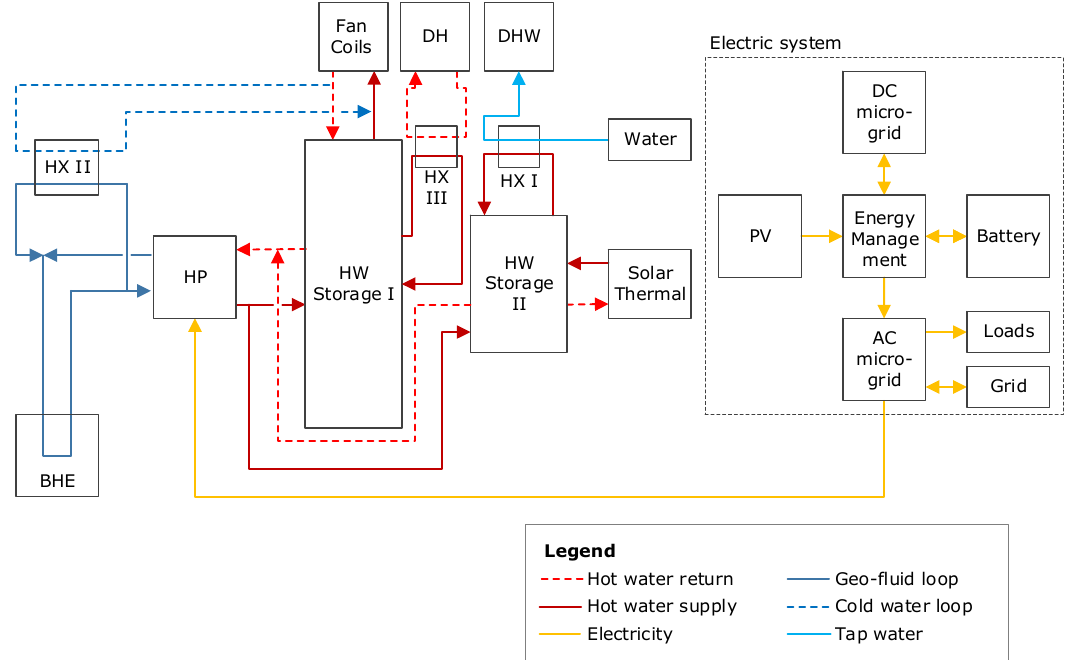
Figure 1. Structure of hybrid thermal energy supply system. BHE—borehole heat exchanger; HX—heat exchanger; DH—district heating; HP—heat pump; HW—hot water; DHW—domestic hot water; PV—photovoltaic panels; DC—direct current.